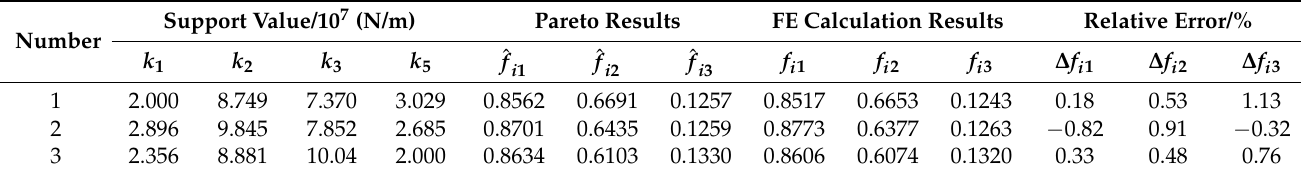
Table 9. Results of solution set selection based on the compromise of objective function.